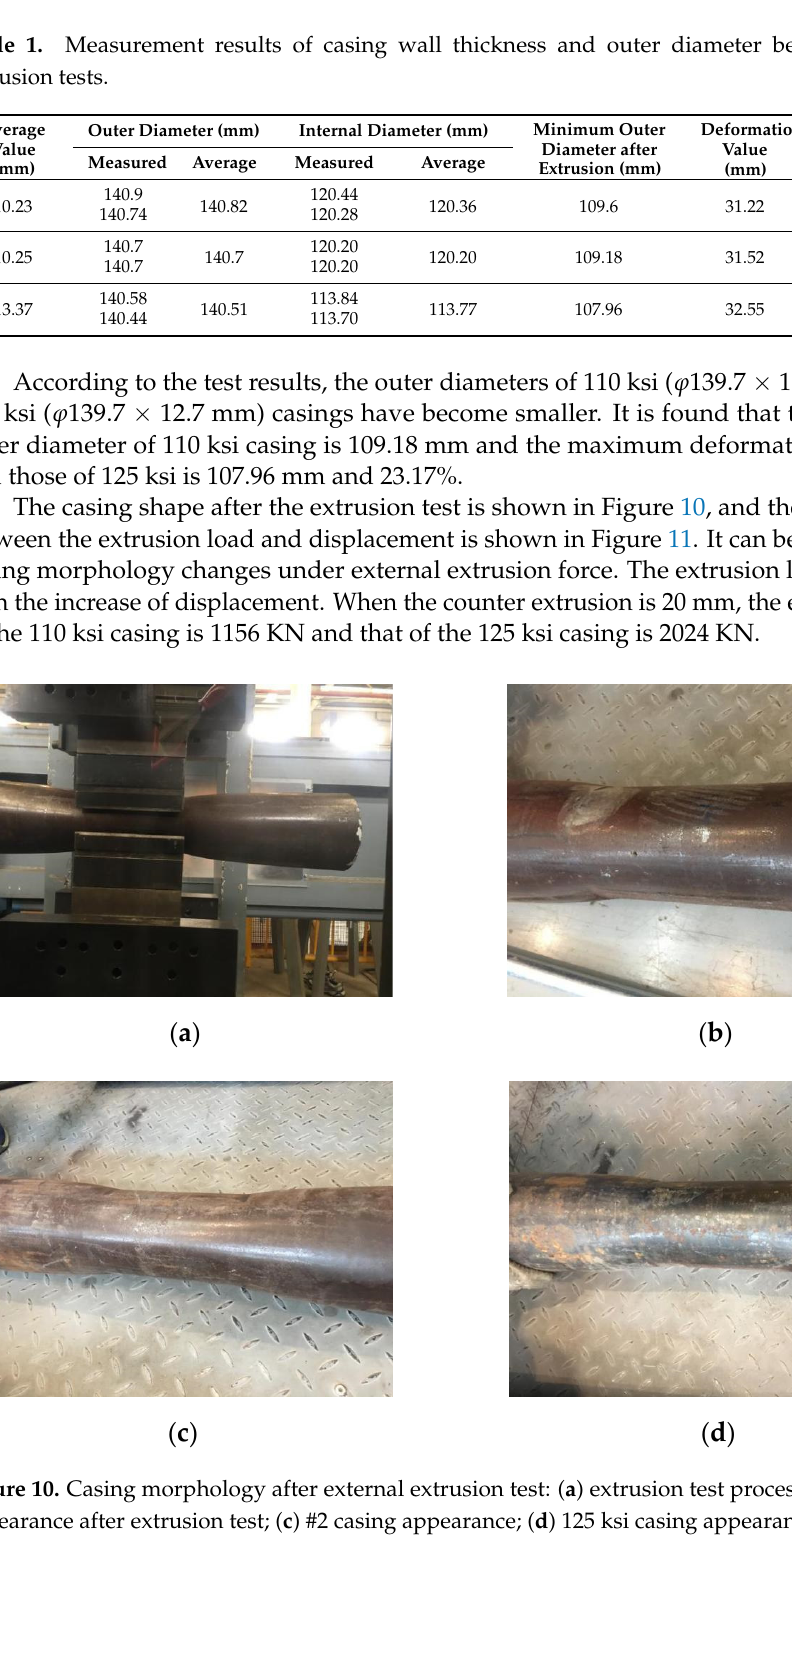
Figure 11. Extrusion load and displacement curve of casing. 4.4. Bearing Characteristics of Cement-Sheath Casing under Non-Uniform Extrusion Condition After extrusion deformation of 20 mm, the outer diameters of 110 ksi ( φ 139.7 × 10.54 mm) and 125 ksi ( φ 139.7 × 12.7 mm) casings become smaller. The minimum outer diame- ter of 110 ksi casing is 118.6 mm and the maximum deformation is 15.65%, and those of 125 ksi is 124.1 mm and 11.7%. Compared with the pure pipe test, it is found that the deformation value is reduced, indicating that the cement sheath has a certain protective effect on the casing. The finite-element numerical simulation data are studied. Compared with the external extrusion of the pipe, the equivalent stress after adding cement sheath is significantly reduced, and the minimum drift diameter calculated by the same method is 78.21 mm. Compared with 79.28 mm of the pure pipe, the diameter is increased by 1.07 mm, and the deformation of the minimum drift diameter is reduced by 1.35%. The casing morphology after the extrusion test is shown in Figure 12, and the rela- tionship between the extrusion load and displacement is shown in Figure 13. It can be seen that the cement sheath is damaged, and cracks appear locally under the extrusion force. The extrusion load increases with the increase of displacement. When the counter extrusion is 15 mm, the extrusion load of 110 ksi casing is 3825 KN and that of 125 ksi casing is 4404 KN. Compared with the pure pipe extrusion load, the extrusion load of 110 ksi casing increases by about 230%, and that of 125 ksi casing increases by about 117%.